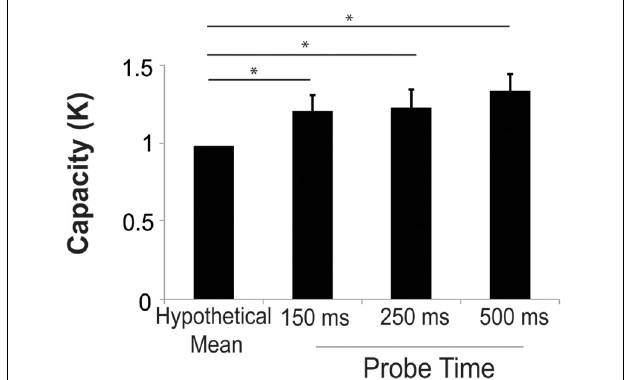
FIGURE 4 | Capacity increased significantly above a hypothetical mean of 1 at all probe durations, suggesting that subjects could successfully deploy their attention to more than one remembered location. Error bars are s.e.m. ∗ p < 0 .